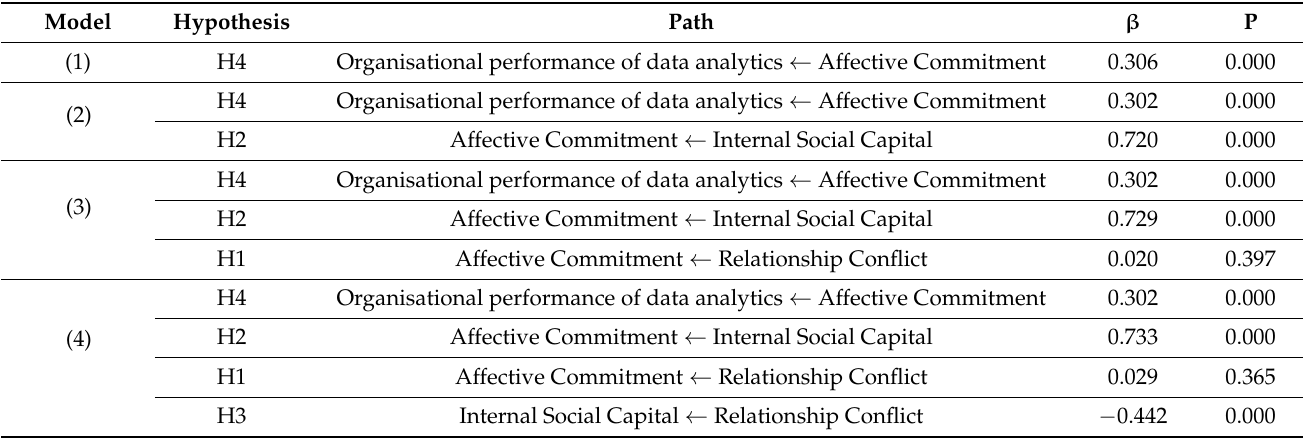
Table 6. Hierarchical regression analysis without